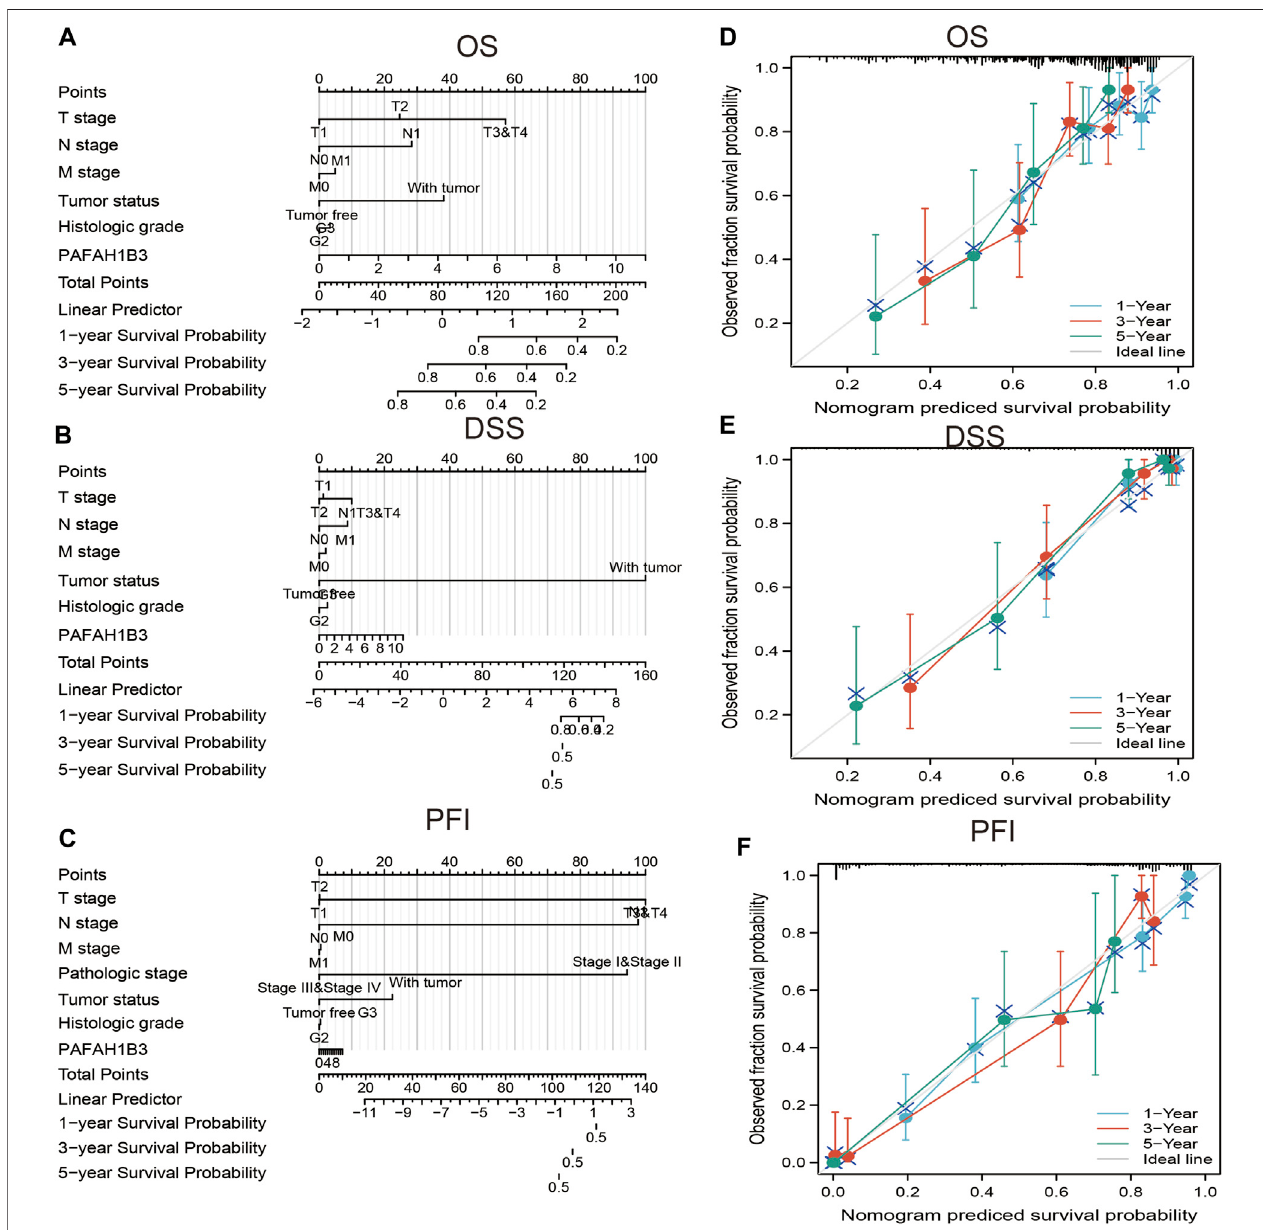
FIGURE 9 | Nomogram and calibration curve for predicting the probability of 1-, 3-, and 5-years OS for LIHC patients. (A – C) A nomogram integrates PAFAH1B3 and other prognostic factors in LIHC from TCGA data, (D – F) The calibration curve of the nomogram.